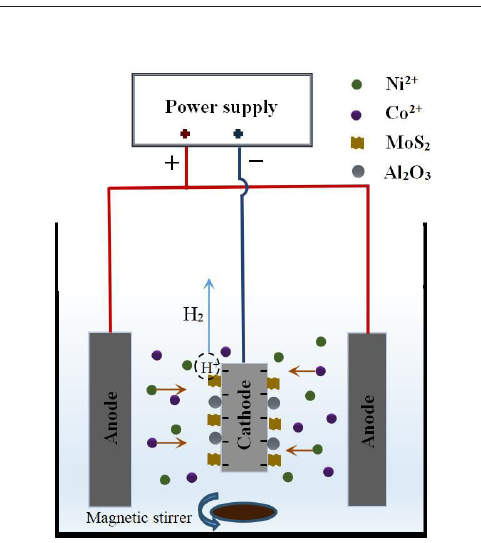
Figure 1. Schematic of the pulse-electrodeposition